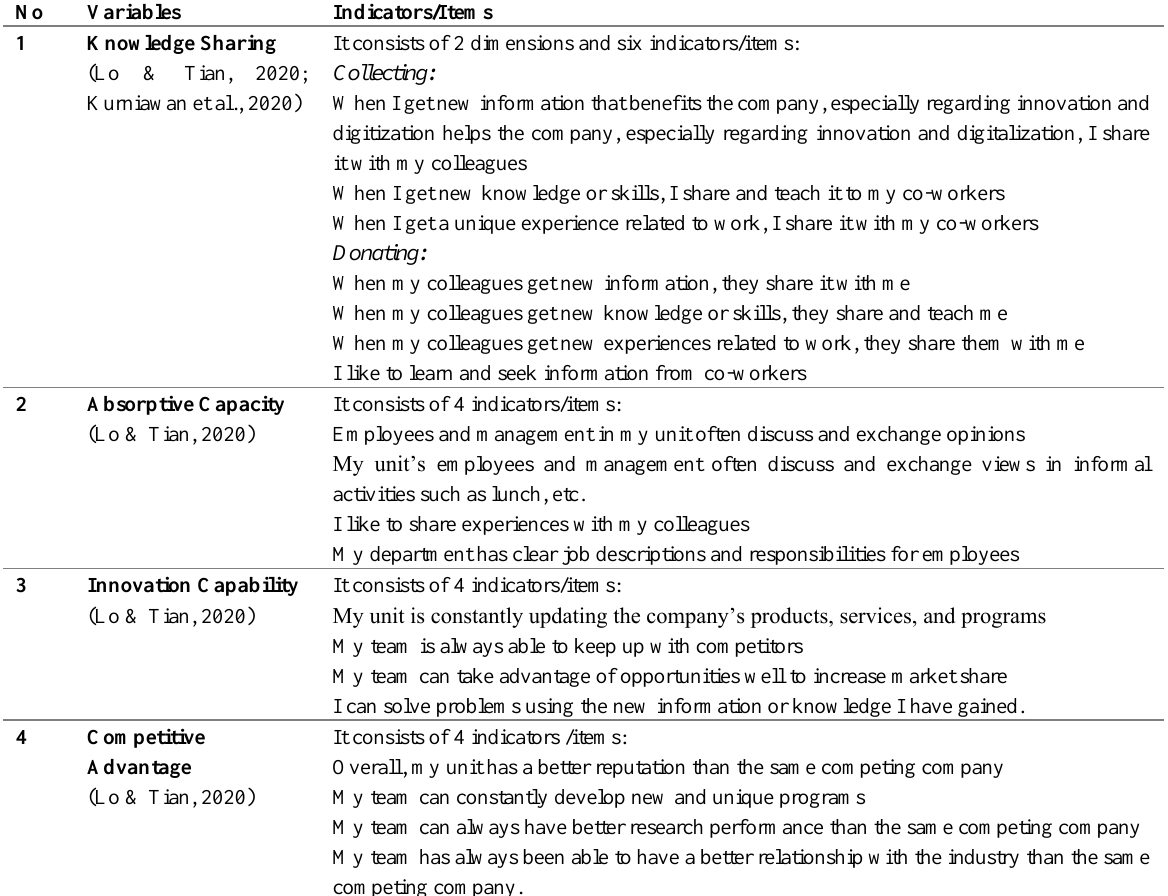
Table 1: Variables, Dimensions, And